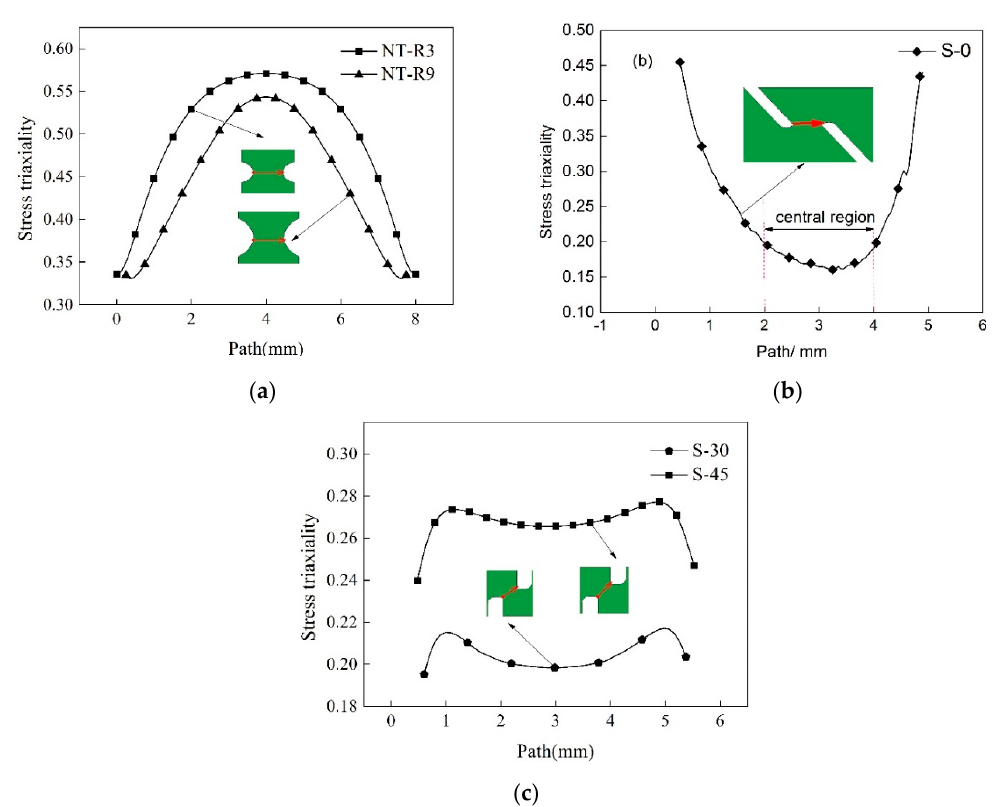
Figure 6. Stress triaxiality along width direction of five specimens. ( a ) NT-R3 and NT-R9; ( b ) S-0; ( c ) S-30 and S-45.